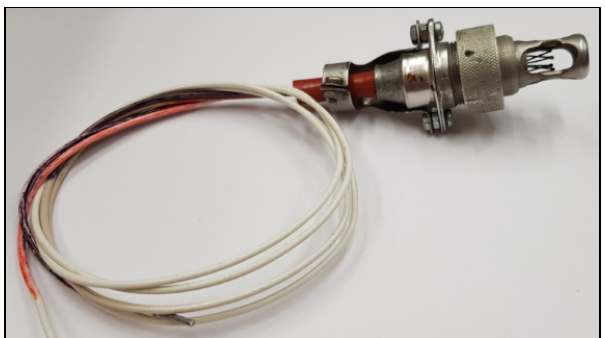
Figure 1. View of the DPS transmitter.